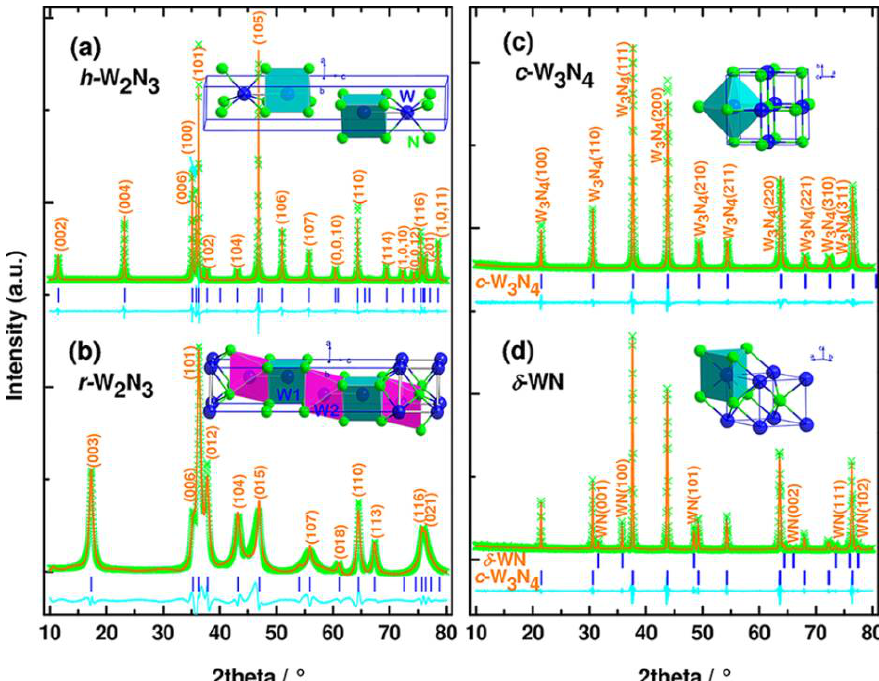
Figure 11. XRD patterns of nitrides in the binary system W−N. The observed (green crosses) and calculated (solid orange lines) profiles for h-W 2 N 3 ( a ) and r-W 2 N 3 ( b ), synthesized at 5 GPa and temperatures of 1480 and 880 K, respectively, and purified by removing by-product NaBO 2 (see Experimental Section); c-W 3 N 4 ( c ) and δ-WN ( d ), prepared from h-W 2 N 3 at 5 GPa and 2273 and 2570 K, respectively. The curves in the cyan color represent the difference between the observed and calculated profiles. Insets are crystal structures of those nitrides. The blue tick marks correspond to the peak positions. Reprinted with permission from Wang et al. “Synthesis, Crystal Structure, and Elastic Properties of Novel Tungsten.” Chemi. Mater. 24, 3023–3028 (2012), Copyright 2012 American Chemical Society. (Ref. 41).